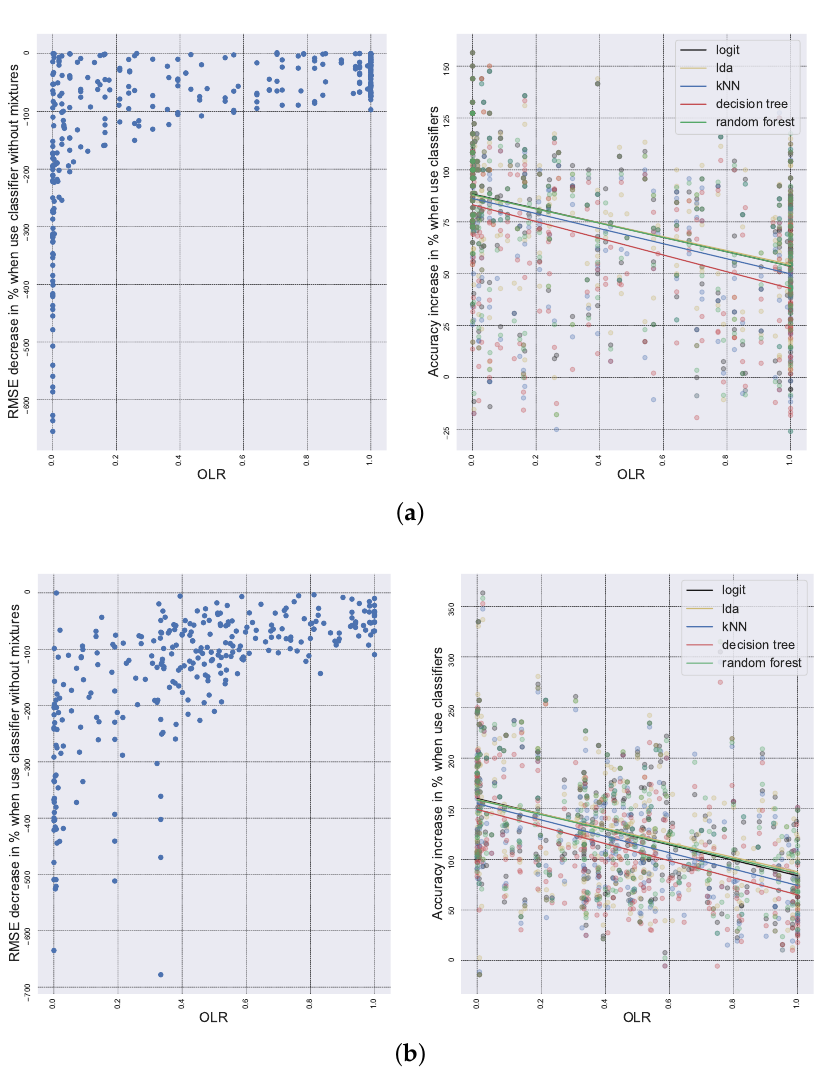
Figure 6. A decrease in the RMSE of a continuous node and an increase in the accuracy in determining the components when the edge is reversed for the two-component ( a ) and three-component ( b ) cases. A negative RMSE value indicates how much the estimate is